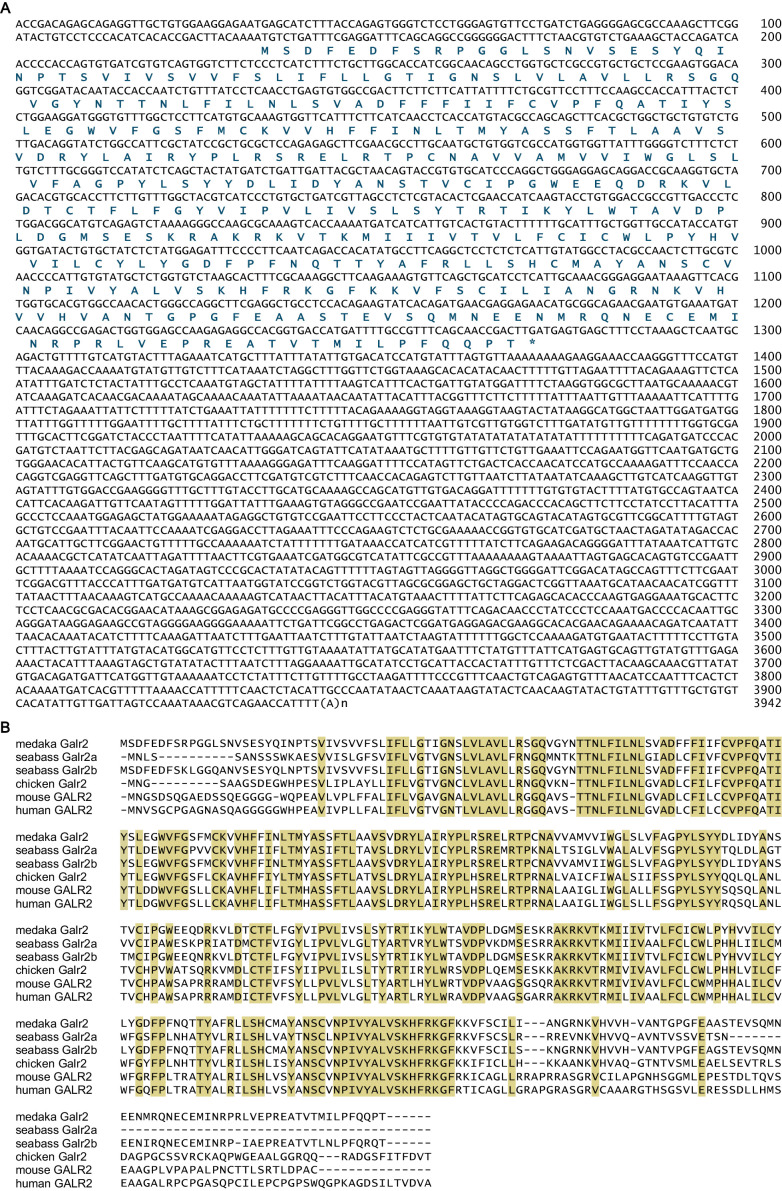
Sequence information for medaka galr2.(A) Nucleotide and deduced amino acid sequences of the medaka galr2 cDNA. Asterisk indicates stop codon. Nucleotide numbers are shown at the right of each sequence line. (B) Sequence comparison of medaka Galr2 and its orthologs in other vertebrate species. Amino acids identical in all sequences are shaded in beige. For species names and GenBank accession numbers, see Supplementary file 2. Supplementary Data List.